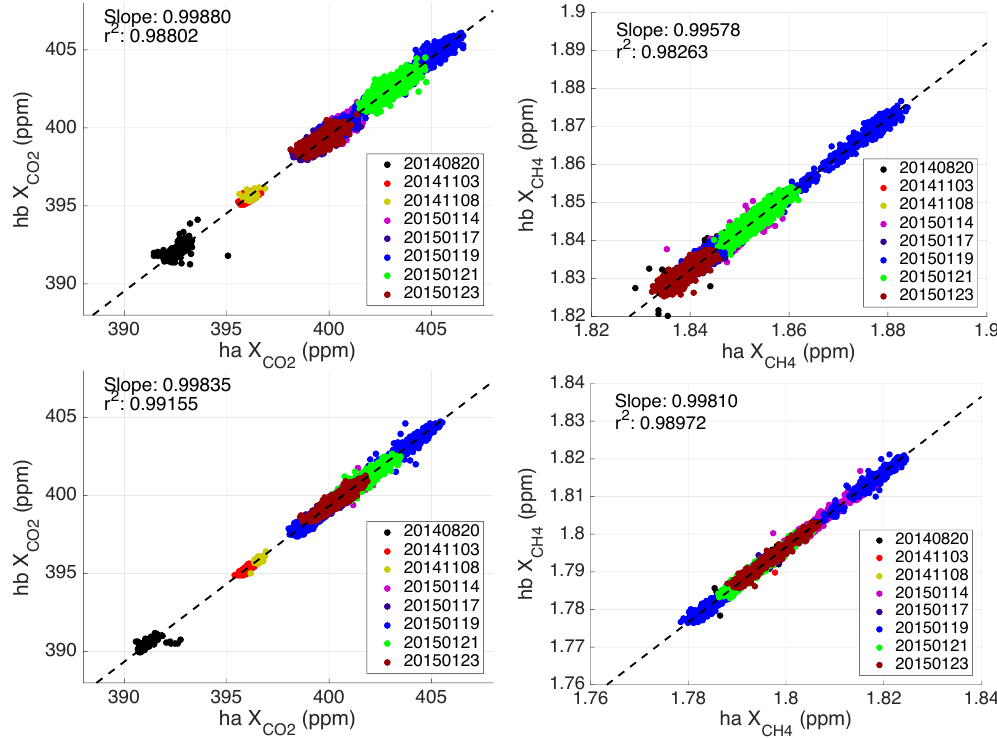
Figure 2. Scatter plots with the slopes representing R G for different days using I2S/GFIT retrieval (top panels) and PROFFIT retrieval (bottom panels). January measurements are carried out in Pasadena, others in Cambridge. The first 4 days are before the field study; others are during the campaign.